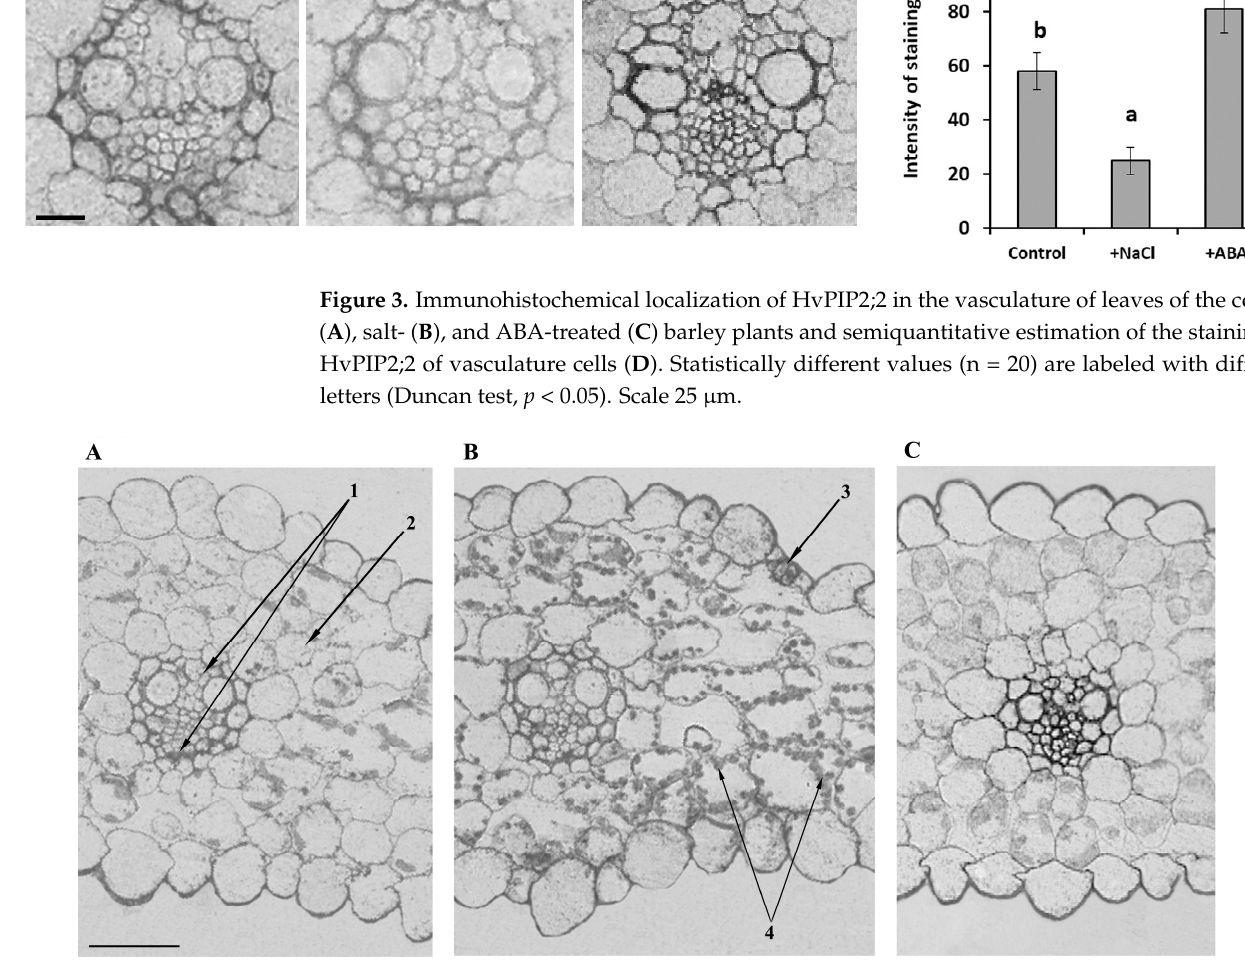
Figure 3. Immunohistochemical localization of HvPIP2;2 in the vasculature of leaves of the control ( A ), salt- ( B ), and ABA-treated ( C ) barley plants and semiquantitative estimation of the staining for HvPIP2;2 of vasculature cells ( D ). Statistically different values (n = 20) are labeled with different letters (Duncan test, p < 0.05). Scale 25 µm.